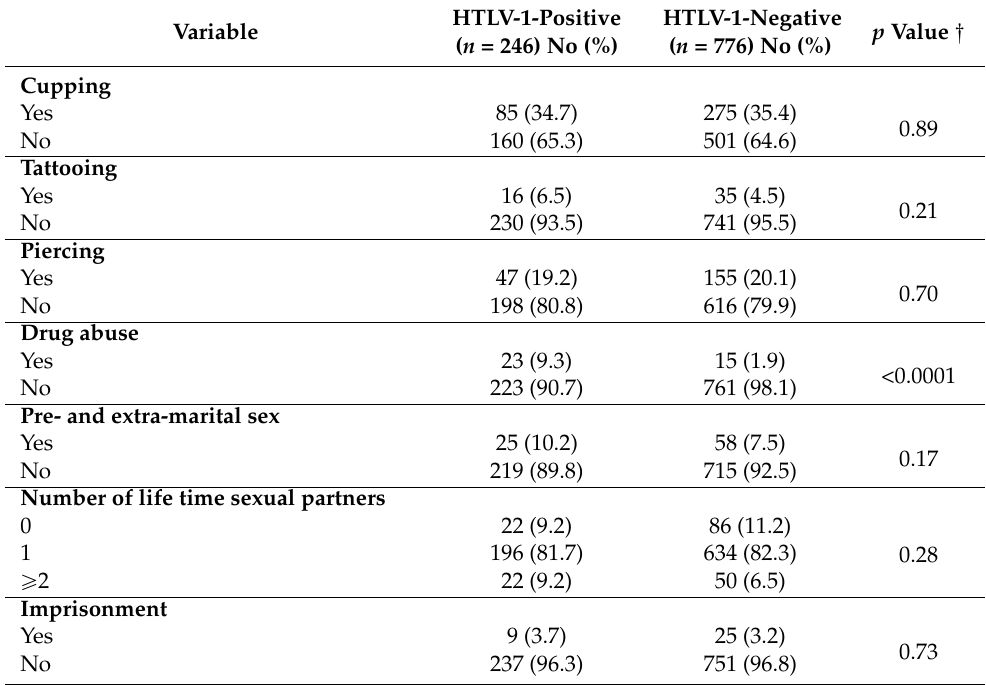
Table 4. Risky behaviors associated with HTLV-1 infection among blood donors.